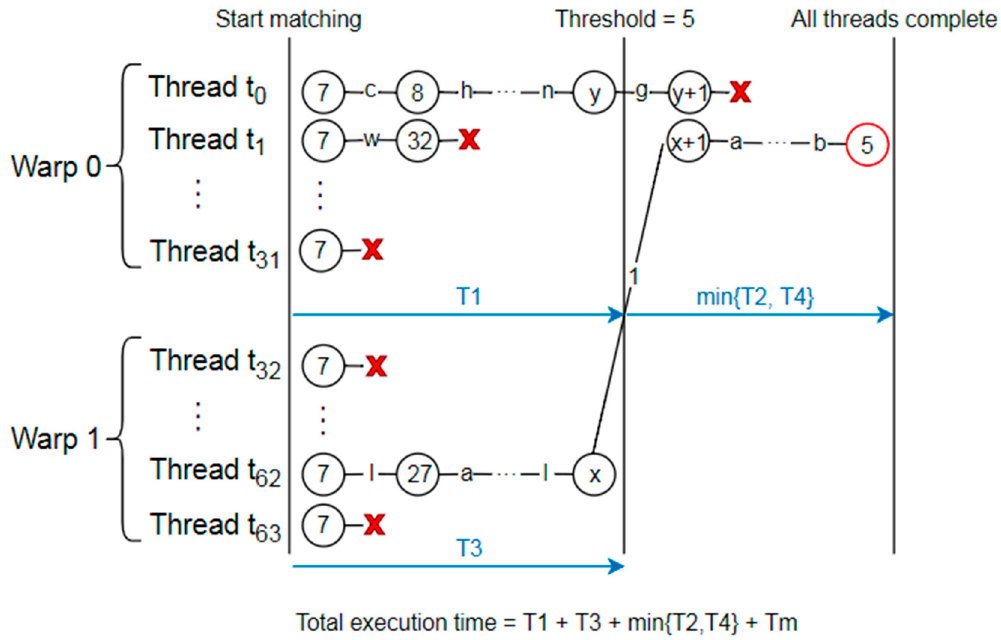
Figure 3. The main idea of the proposed two-phase PFAC algorithm.